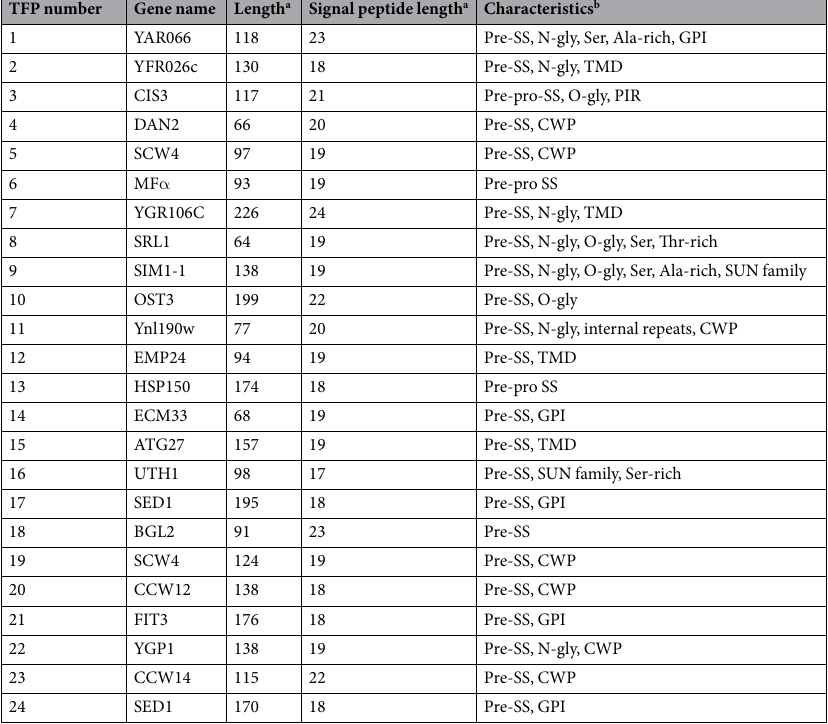
hydrolysis activity of ClCBH2 by TFP 13 were 2.4-fold and 1.4-fold more efficient than those obtained by the native signal peptide and MF α , respectively. The cellulose hydrolysis activity of ClCBH2 secreted by TFP 13 (TFP13-ClCBH2) was approximately 2.4 and 2.8 times higher than that of TrCBH2 secreted by TFP 13 and of PaCel2 secreted by TFP 13, respectively. These results suggest that a native secretion signal of CtCBH1 is better